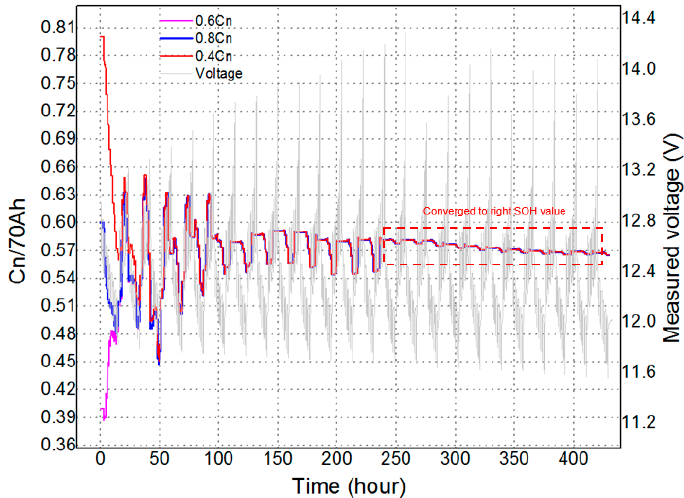
Figure 12. The convergence of the SOH estimation result with different initial capacity values (The measured capacity of the battery is 59.3% SOH).